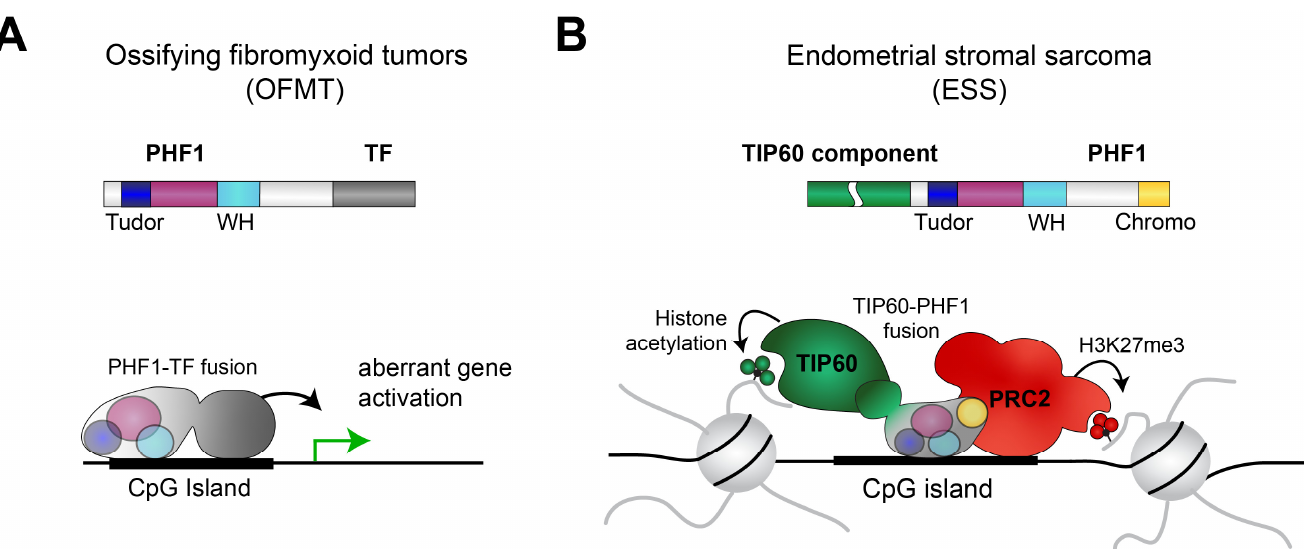
Figure 3. ( A ) Common PHF1 rearrangements in OFMT consist of the N-terminal part of PHF1 and transcription factors (TF), such as FOXR1, FOXR2, and TFE3. Consequently, the resulting fusion protein may be aberrantly recruited to the wrong locations in the genome, leading to dysregulated gene expression. ( B ) In ESS, full-length PHF1 is recurrently fused to components of the TIP60 complex, such as TEAF1, JAZF1, EPC1, and EPC2 (see also Table 1). The resulting protein can interact with both the TIP60 and the PRC2 complexes [62], leading to aberrant chromatin states in cancer cells.